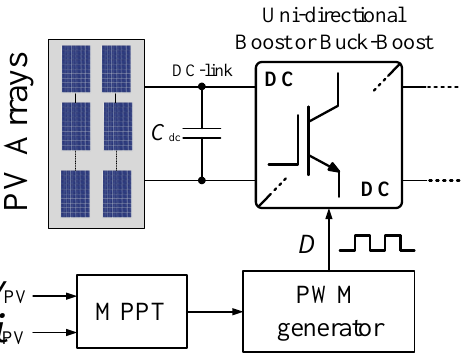
Figure 6. PV-interfaced unidirectional DC – DC converter equipped with MPPT.